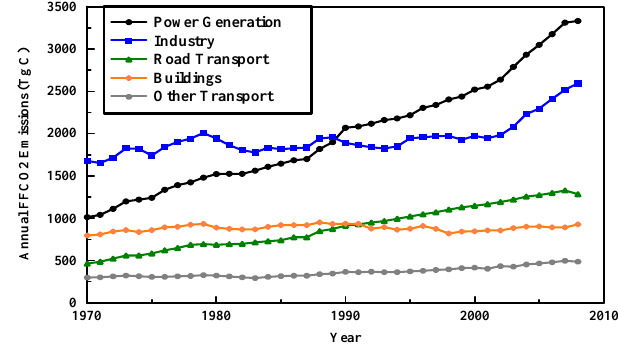
Fig. 3c. Cumulative FFCO2 emissions from the year 1751 to 2007. This figure was created from summing the data in Fig. 3a. The dashed line indicates when approximately 50% of emissions have been emitted. Data from Boden et al. (2010).